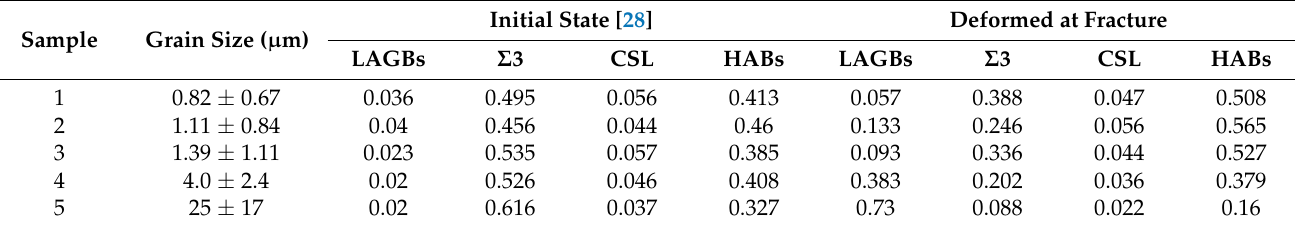
Table 2. Grain boundary character distribution (GBCD) of samples in the initial state and deformed at fracture. Sample Grain Size ( µ